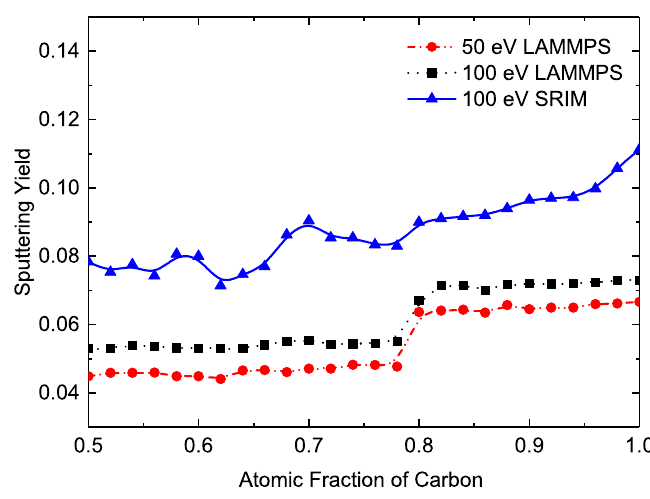
Figure 2. Sputtering yield as a function of the concentration of carbon (50–100 at %). LAMMPS: large-scale atomic molecular massively parallel